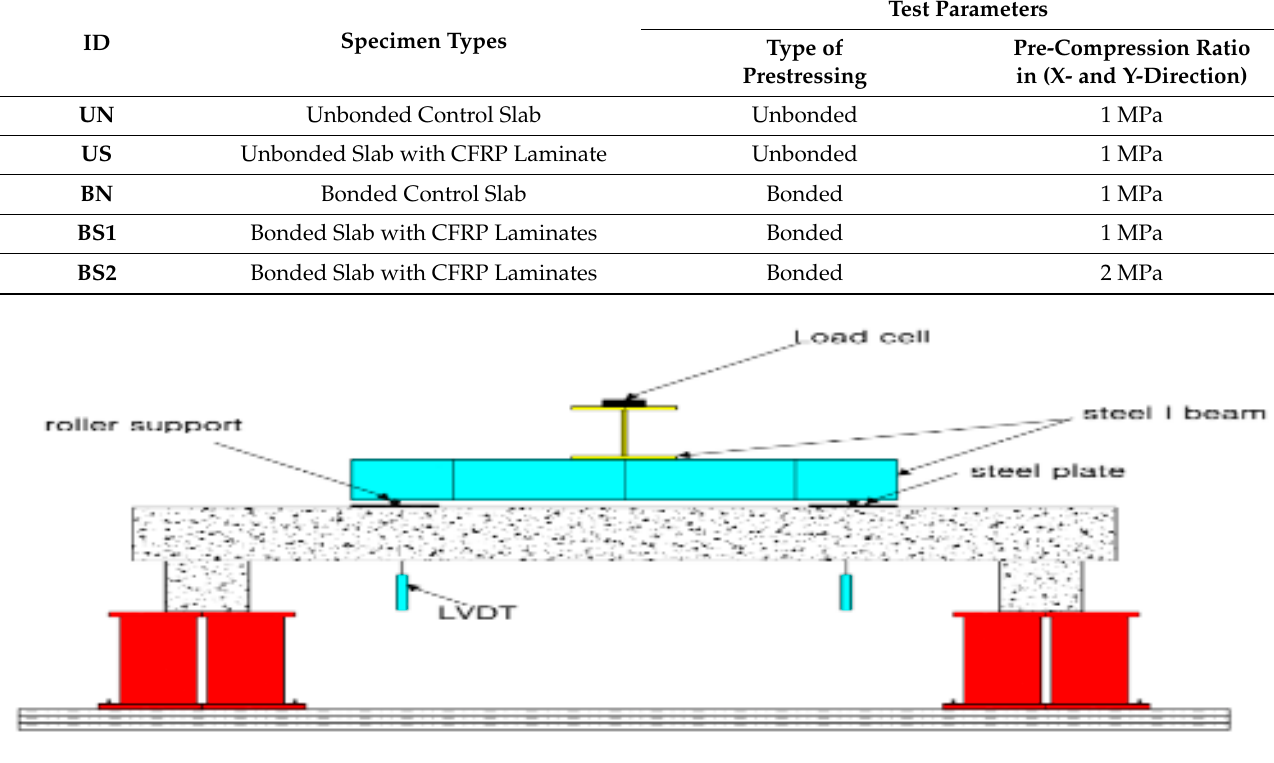
Figure 1. Typical details for all slabs [33]. Table 1. Summary of specimen’s type.